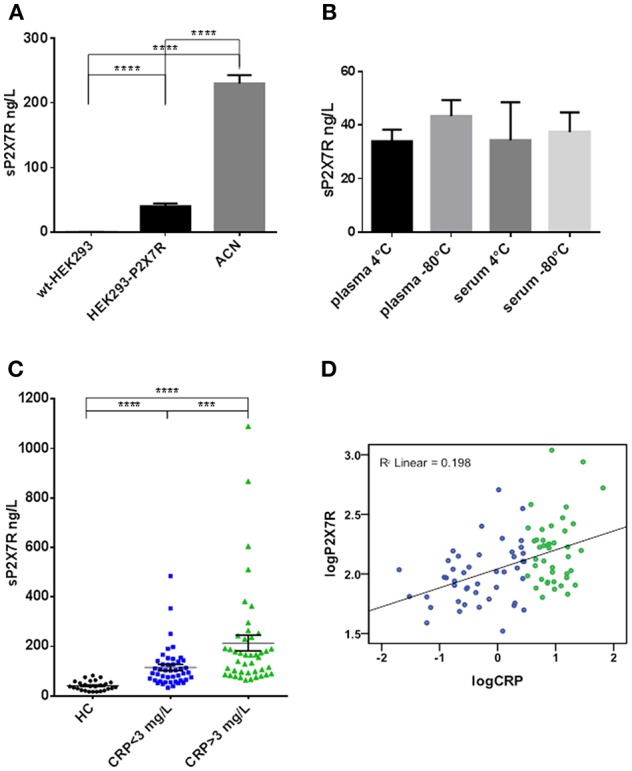
The P2X7R was present in human plasma and serum, its concentration was higher in diseased subjects and correlated with CRP. (A) ELISA analysis for sP2X7R of lysates from 108 cells/ml of wt-HEK293, HEK293-P2X7R, and ACN neuroblastoma cells. Data are means ± SE of results from 3 separate experiments. Differences are statistically significant (One-way ANOVA, p < 0.0001; unpaired t-test between groups: ****p < 0.0001). (B) Effect of storage conditions on sP2X7R detection by ELISA in plasma and serum samples from 4 healthy subjects. Differences are not statistically significant. (C) sP2X7R levels were measured by ELISA in serum samples from 26 healthy control subjects (HC), 45 patients with CRP <3 mg/L and 42 patients with CRP >3 mg/L. Data are means ± SE. Mann Whitney test between groups: ***p < 0.001; ****p < 0.0001. (D) Linear regression analysis between log-transformed CRP and sP2X7R concentrations in serum samples from 87 diseased subjects. Color coding in (C,D): blue, CRP <3 mg/L, green. CRP >3 mg/L.